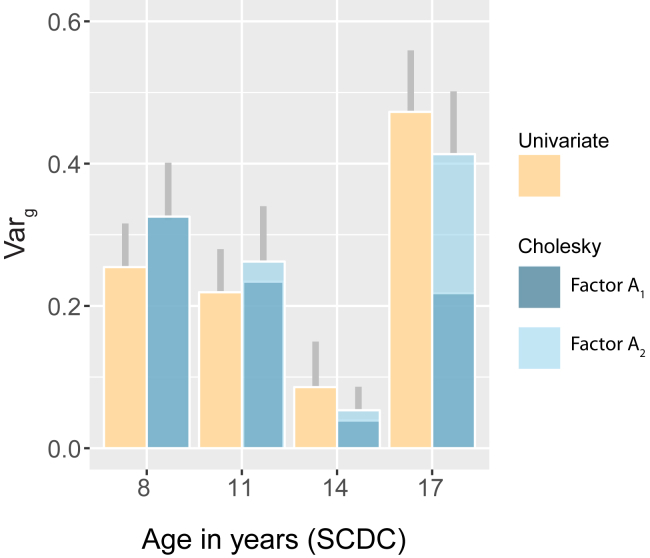
Genetic variance (Varg) of Social Communication Disorder Checklist (SCDC) scores during development. Varg for SCDC scores across development as estimated using a univariate model (Supplemental Table S6) (N ≥ 4174) and the full Cholesky decomposition model (Table 1, model 1, and Supplemental Table S8) (N = 3295). Genetic factors A3 and A4 of the Cholesky decomposition model are not shown, as their estimated Varg was negligible (< 0.01). All reported Varg estimates are equivalent to SNP-h2 estimates. Gray lines indicate 1 SE in total Varg for each SCDC measure.